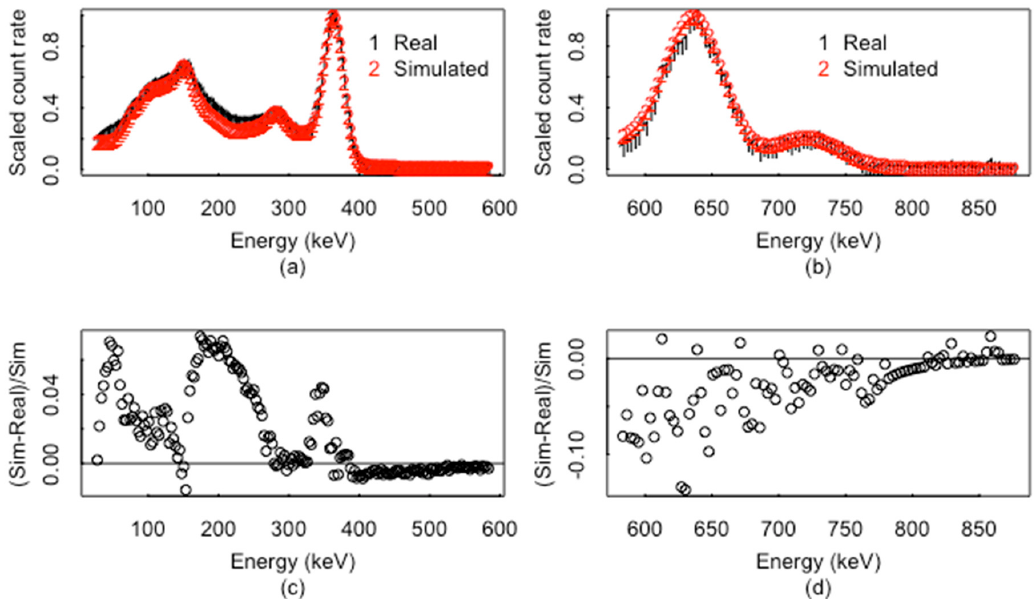
Figure 2. Similar to Figure 1, but for 2 energy regions: simulated and real I-131 spectra in ( a , b ). The real data are background adjusted, but model bias remains, as seen in ( c , d ).